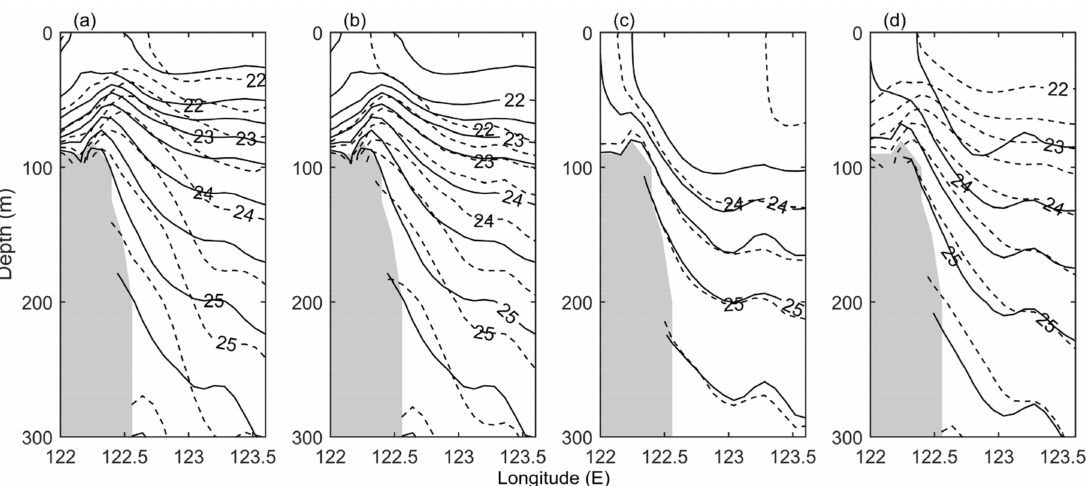
Figure 12. Mean potential density (unit: kg m − 3 ) along the P transect ( a ) during the P1 (dashed lines) and P2 (solid lines) periods, ( b ) during the P2 (solid lines) and P3 (dashed lines) periods, ( c ) during the P4+ (solid lines) and P4 − (dashed lines) periods and ( d ) from May 2017 to October 2017 (solid lines) and from November 2017 to April 2018 (dashed